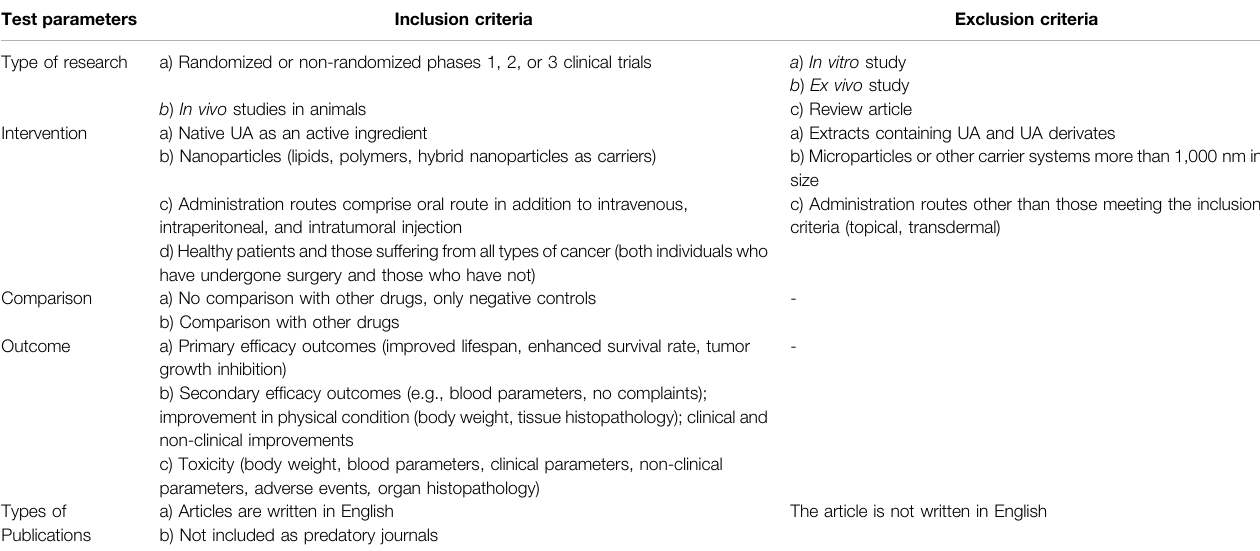
TABLE 1 | The inclusion and exclusion criteria for article screening and